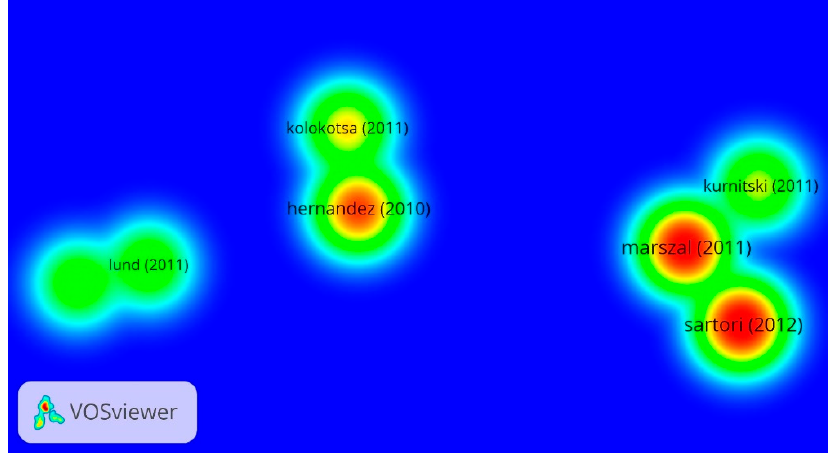
Figure 6. Citation map representing influential studies (net zero).